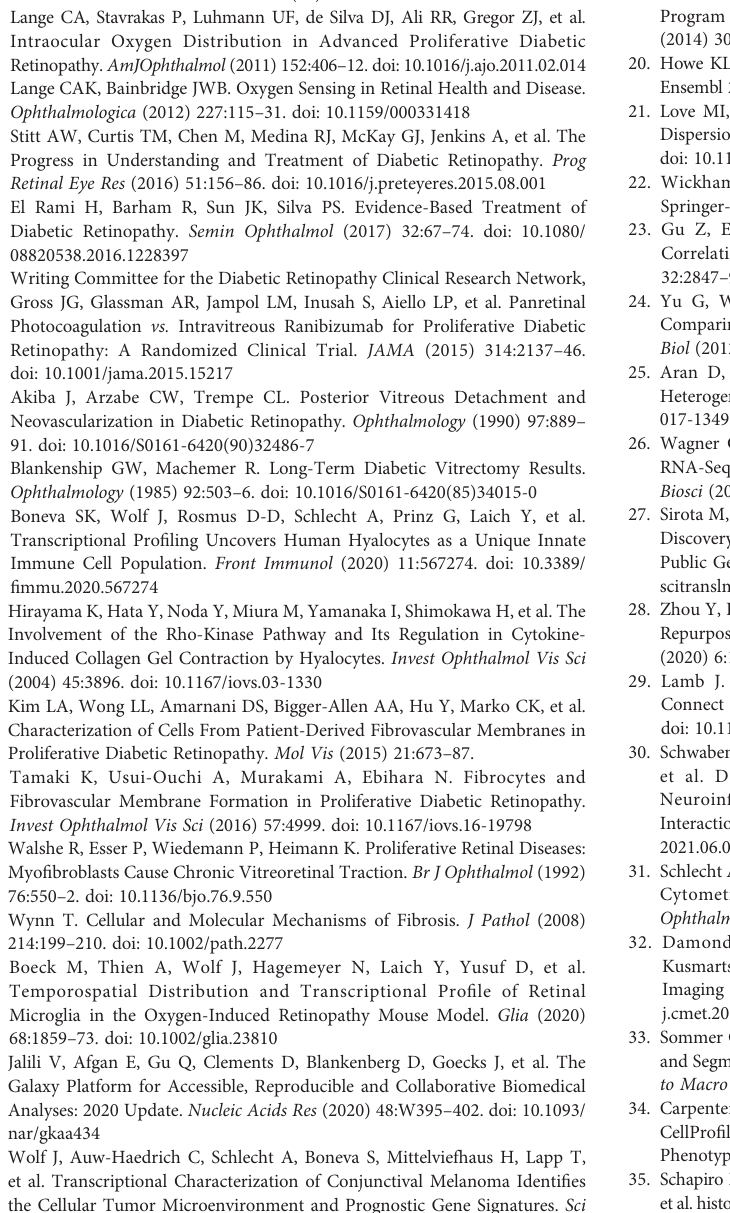
Nuclei are counterstained with DAPI (4 ′ ,6-Diamidin-2-phenylindol). Scale bars correspond to 100 m m. Supplementary Figure3 | Imaging Mass Cytometry onretinal neovascularization and epiretinal membranes: representative sections of all plausible stainings. Supplementary Figure 4 | Immunohistochemicalstainingofplatedhyalocytesfroma PDRpatient.IBA-1(green), a -SMA(yellow)andPhalloidin(red).Nucleiarecounterstained withDAPI(4 ′ ,6-Diamidin-2-phenylindol). Scale bars correspondto25 m